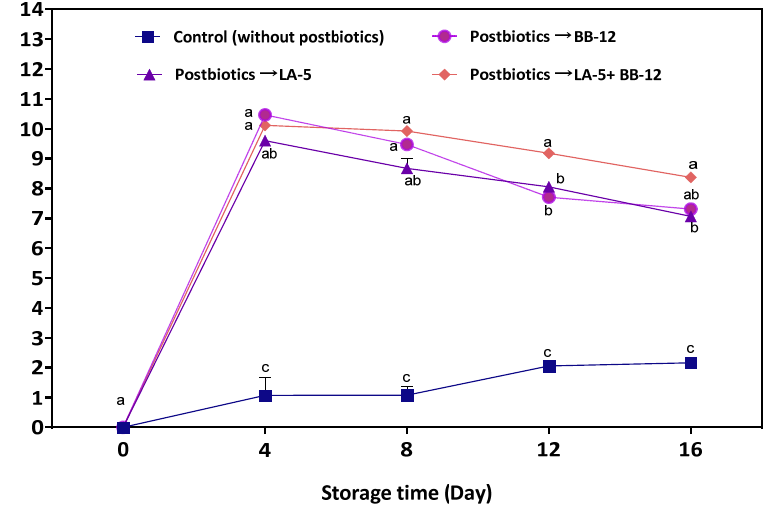
Figure 3. The color difference in cheese samples preserved in postbiotic solutions from L. acidophilus LA-5 (P-LA-5), B. animalis BB-12 (P-BB-12), and their combination during 16 days of storage. Different